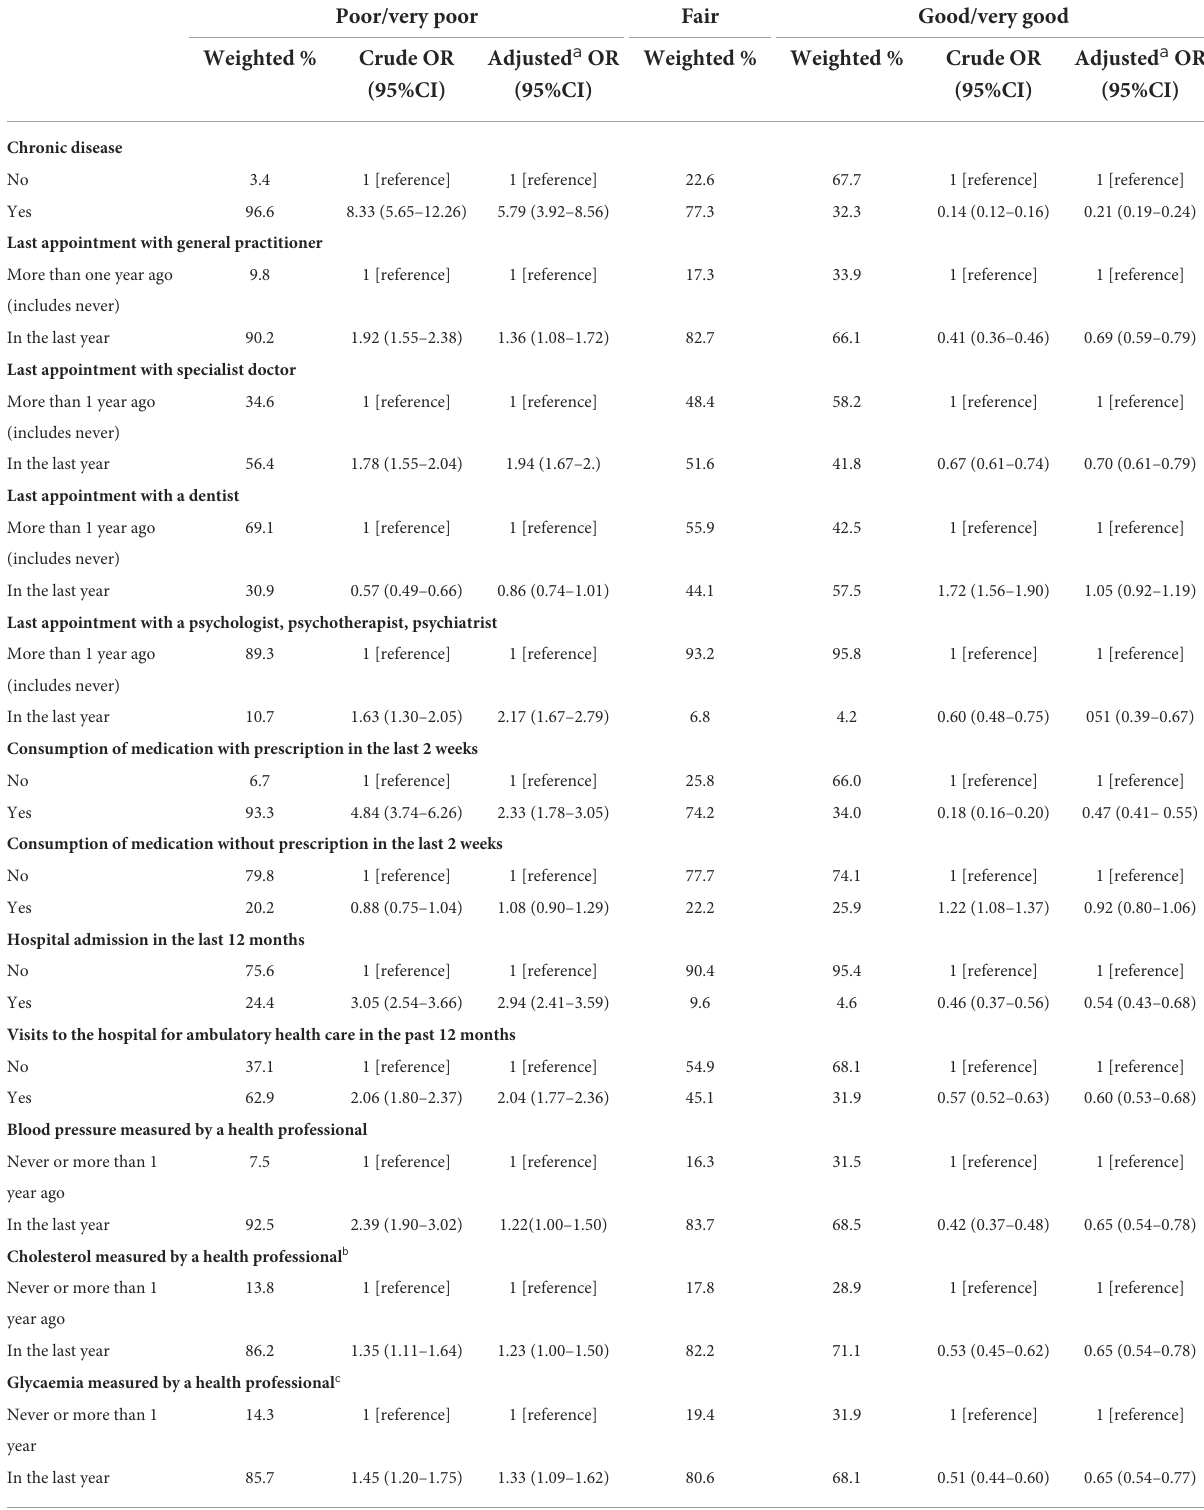
TABLE 3 Association between objective health status and healthcare use, and self-perceived health status. Self-perceived health status Poor/very poor